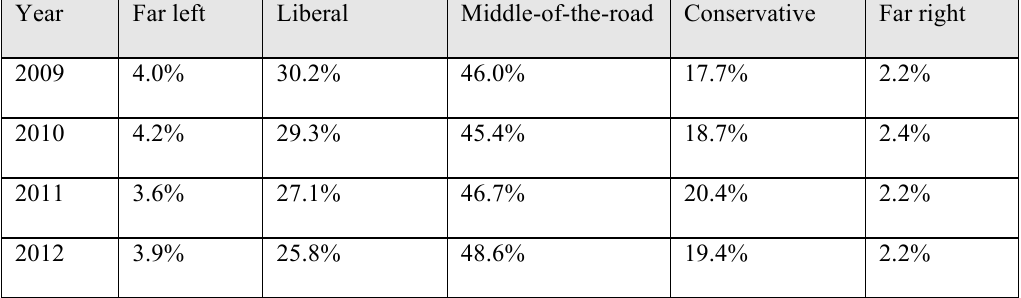
CIRP Institutional Data on Entering Male Freshmen at All Private Nonsectarian